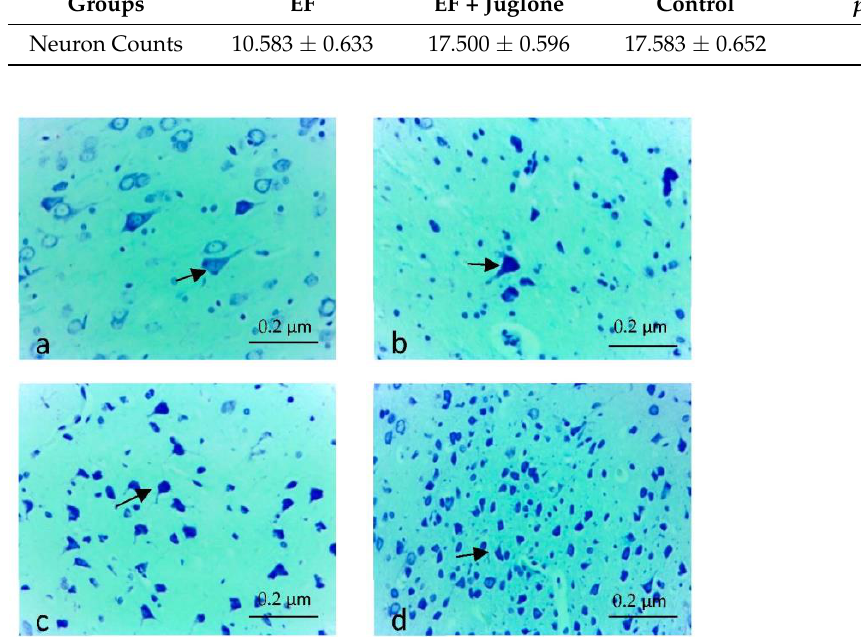
Figure 1. ( a , b ) Density of neurons in the electric field group (arrows), decrease in neuron density, Luxol Fast Blue-Cresyl Violet Staining, ×40; ( c ) Neuron density in the electric field + Juglone group (arrows), increased in neuron density, Luxol Fast Blue-Cresyl Violet, ×40; ( d ) Neuron density in the control group (arrows), increased in neuron density, Luxol Fast Blue-Cresyl Violet, ×40.